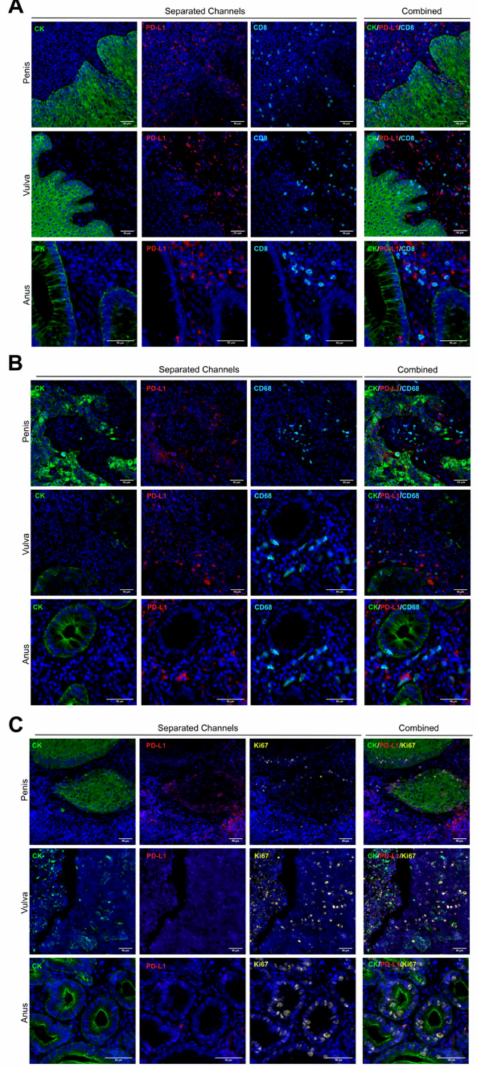
Figure 2. Multiplexed biomarker staining patterns. Whole tissue sections were assessed by mul- tiplexed immunofluorescence. Staining patterns for each biomarker are shown in separated and combined channels, and the images are representative for all cores and tumor types. The cytokeratin CK and PD-L1 area are pseudo-colored in green and red, respectively ( A – C ). CD8 ( A ) and CD68 ( B ) are presented in cyan, and Ki67 is was colored in yellow ( C ). 20 × of magnification. Scale bar represents 50 µ